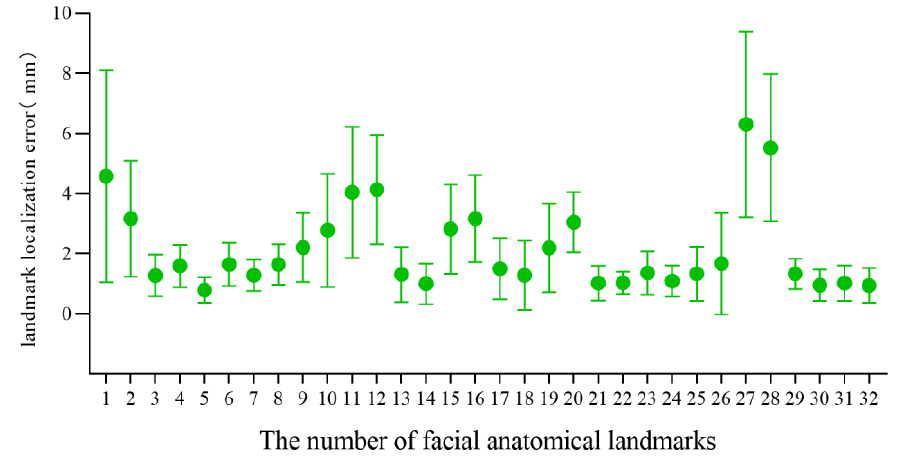
Figure 6. Landmark localization error for each facial anatomical landmark in the MM group.